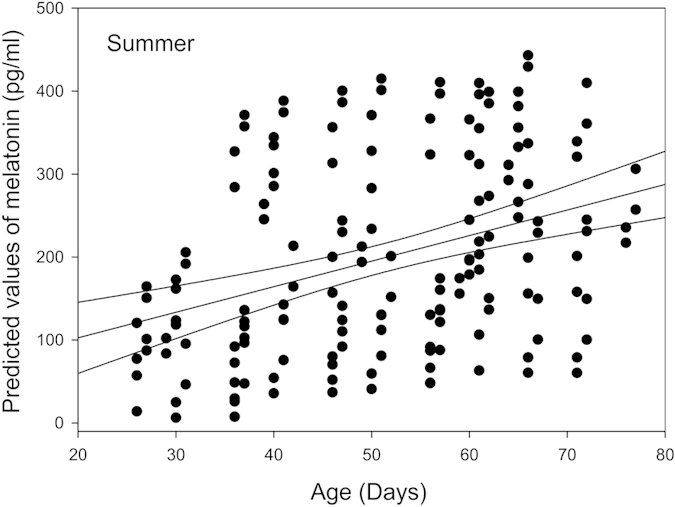
Predicted values of melatonin concentrations (pg/ml) in summer plotted against the age of the calves with a confidence interval (95%).